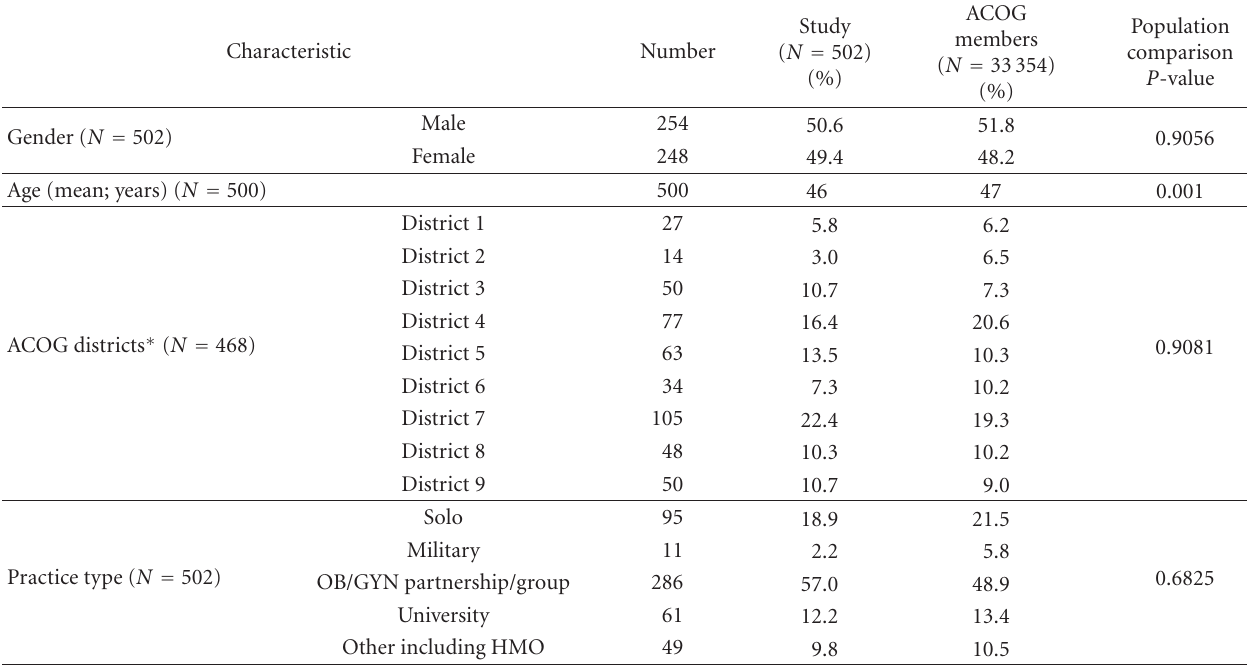
Table 1: Demographics for the survey sample of obstetrician-gynecologists and the American College of Obstetricians and Gynecologists (ACOG),